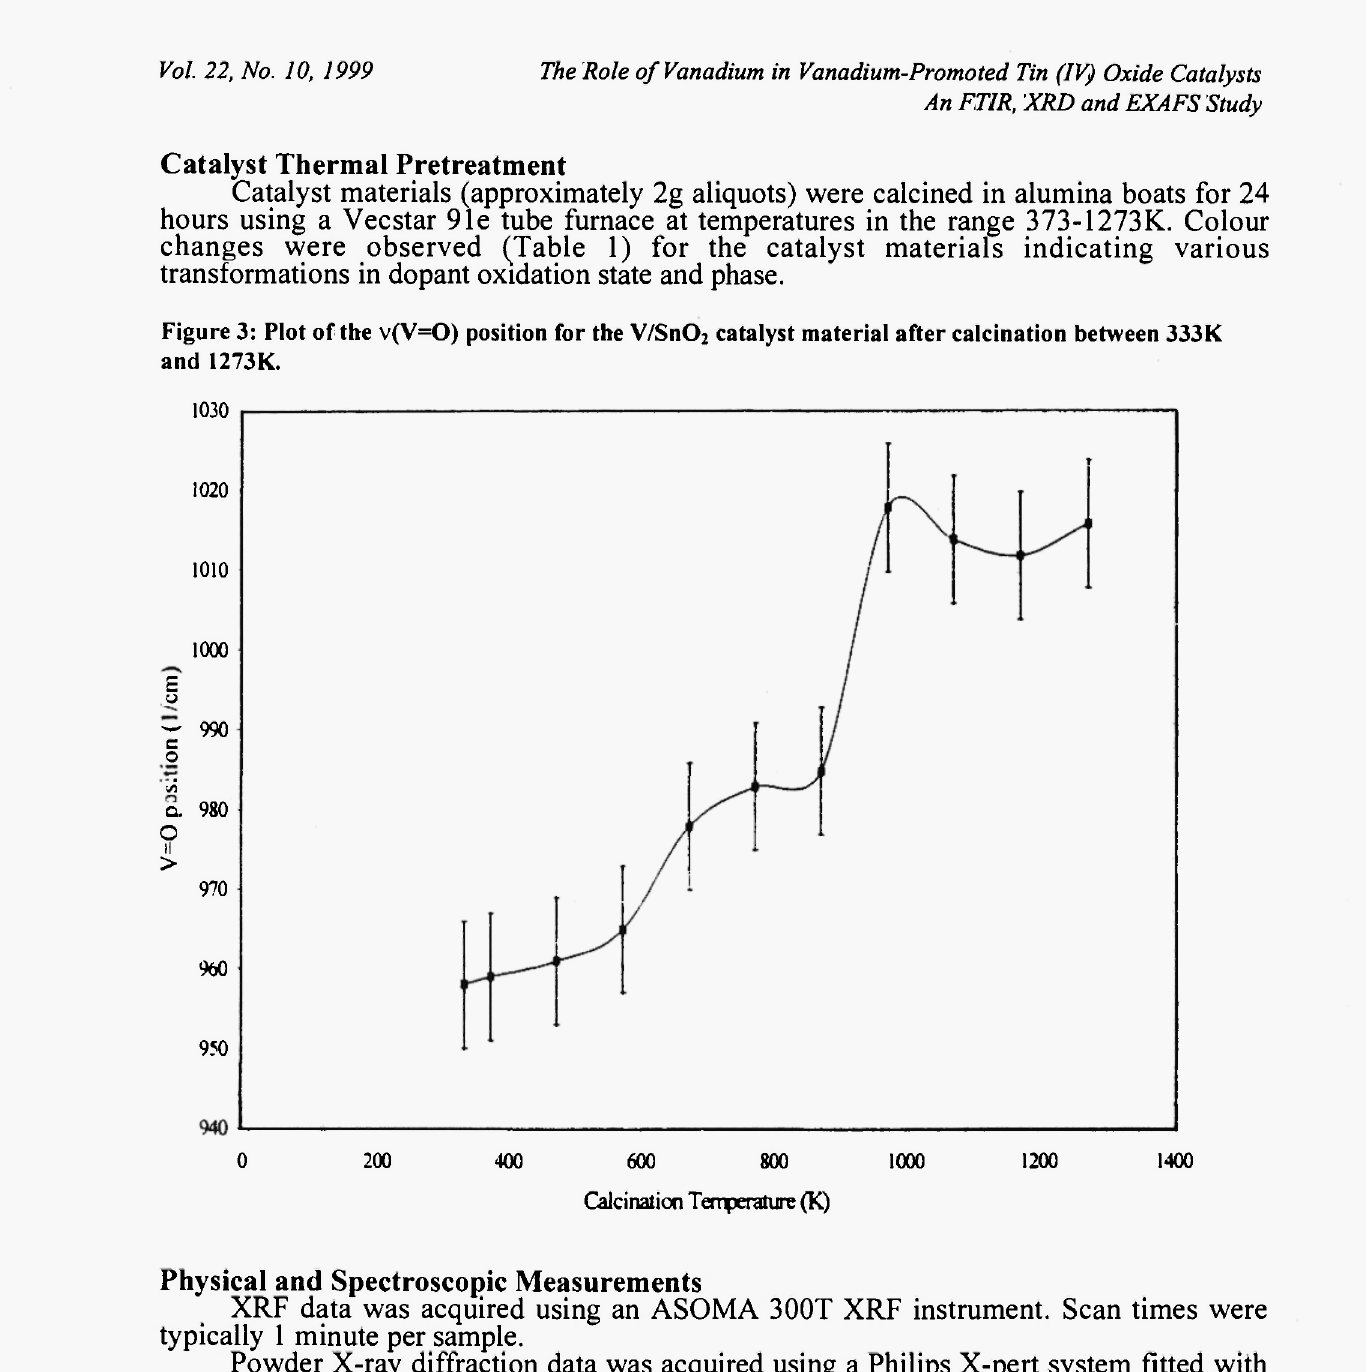
Figure 3: Plot of the v(V=0) position for the V/Sn0 2 catalyst material after calcination between 333K and